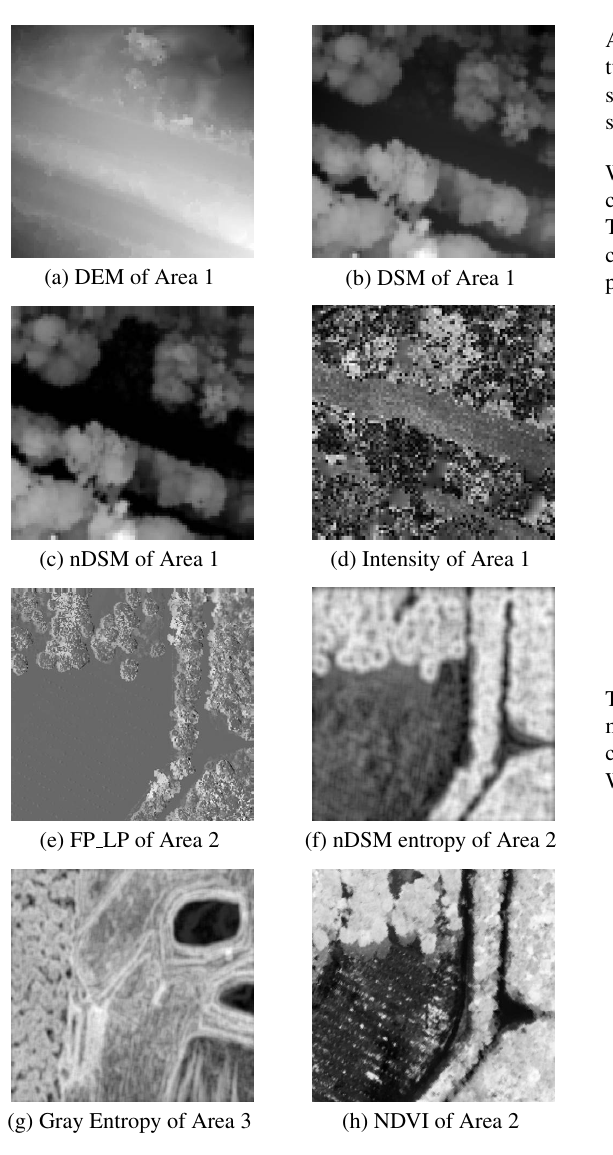
performs Random forests and Maximum likelihood